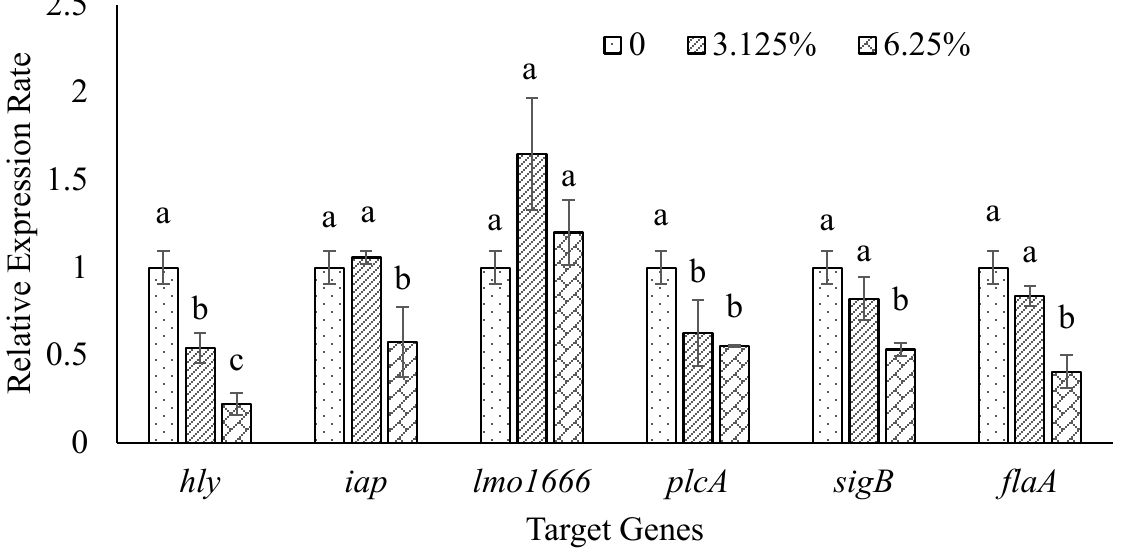
Figure 3. Relative expression levels of selected genes in L. monocytogenes after treatment with 6.25%, 3.12%, or no ohelo berry juice. Bars labeled with different letters indicate significant differences between the means of treatments at p < 0.05.